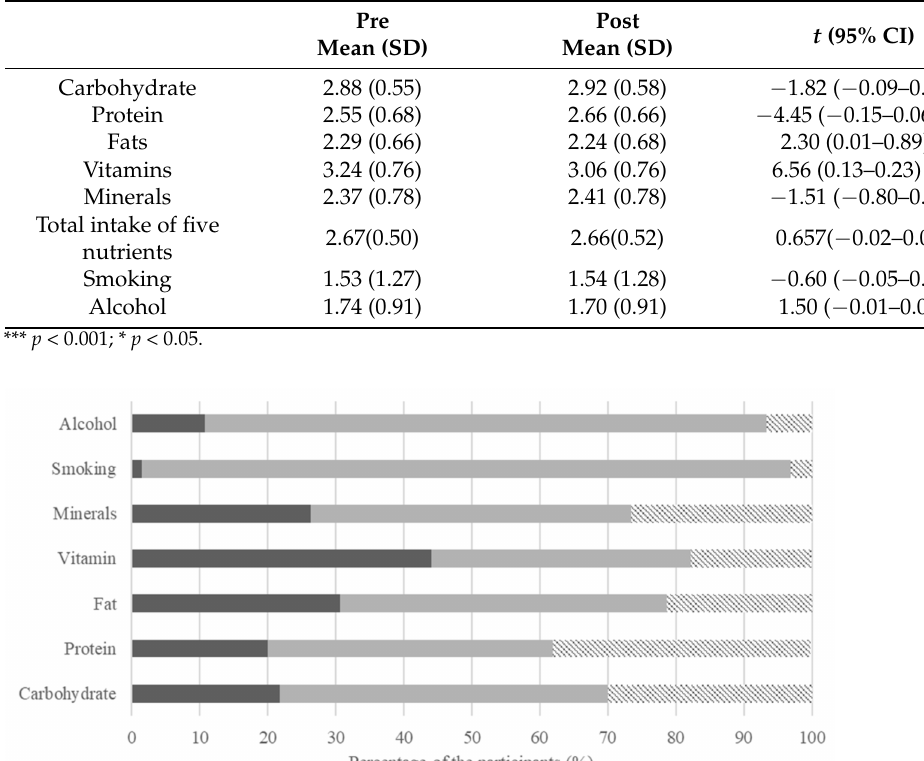
Table 4. Self-reported nutritional intake frequency of periods pre and post COVID-19 pandemic which were assessed via a single questionnaire collected post COVID-19 pandemic ( n = 327).